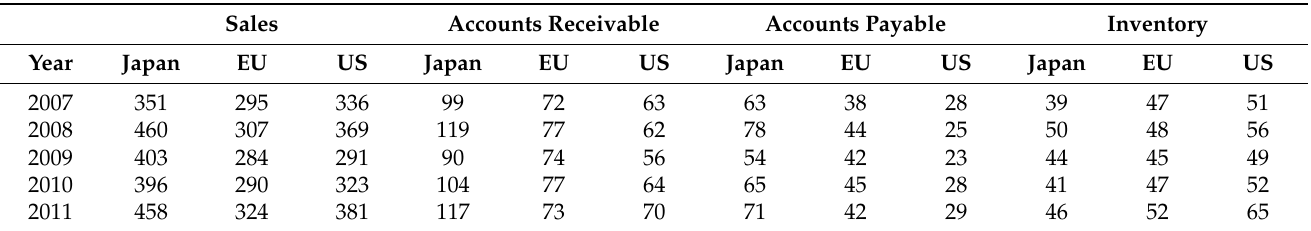
Table 2. Median of sales, accounts receivable and accounts payable in Japan, EU and US between 2007 and 2011 (in millions of dollars).